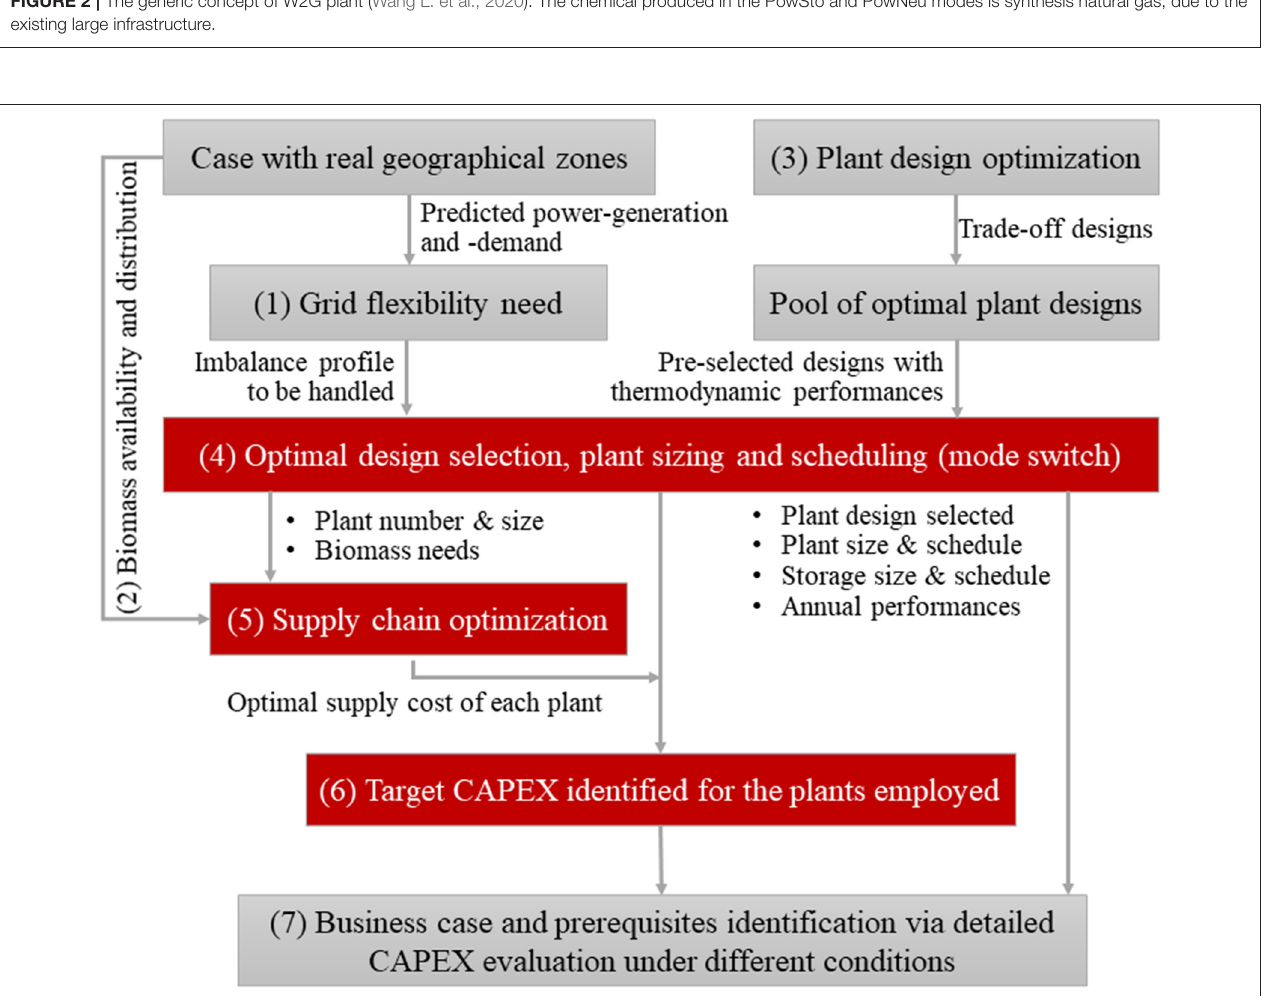
FIGURE 3 | The decomposition-based method to identify potential business cases for the triple-mode grid-balancing plants, adapted from Wang L. et al. (2020).